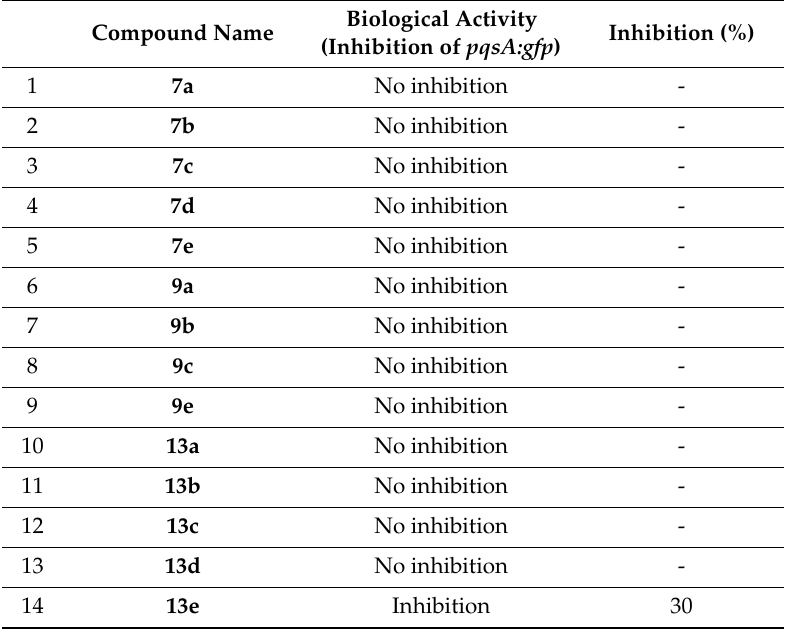
Table 1. PQS inhibition by synthesized compounds using PAO1 pqsA:gfp reporter-based assay.